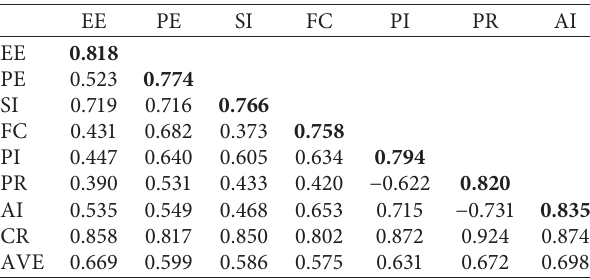
Table 5: Analysis results of discriminant validity.